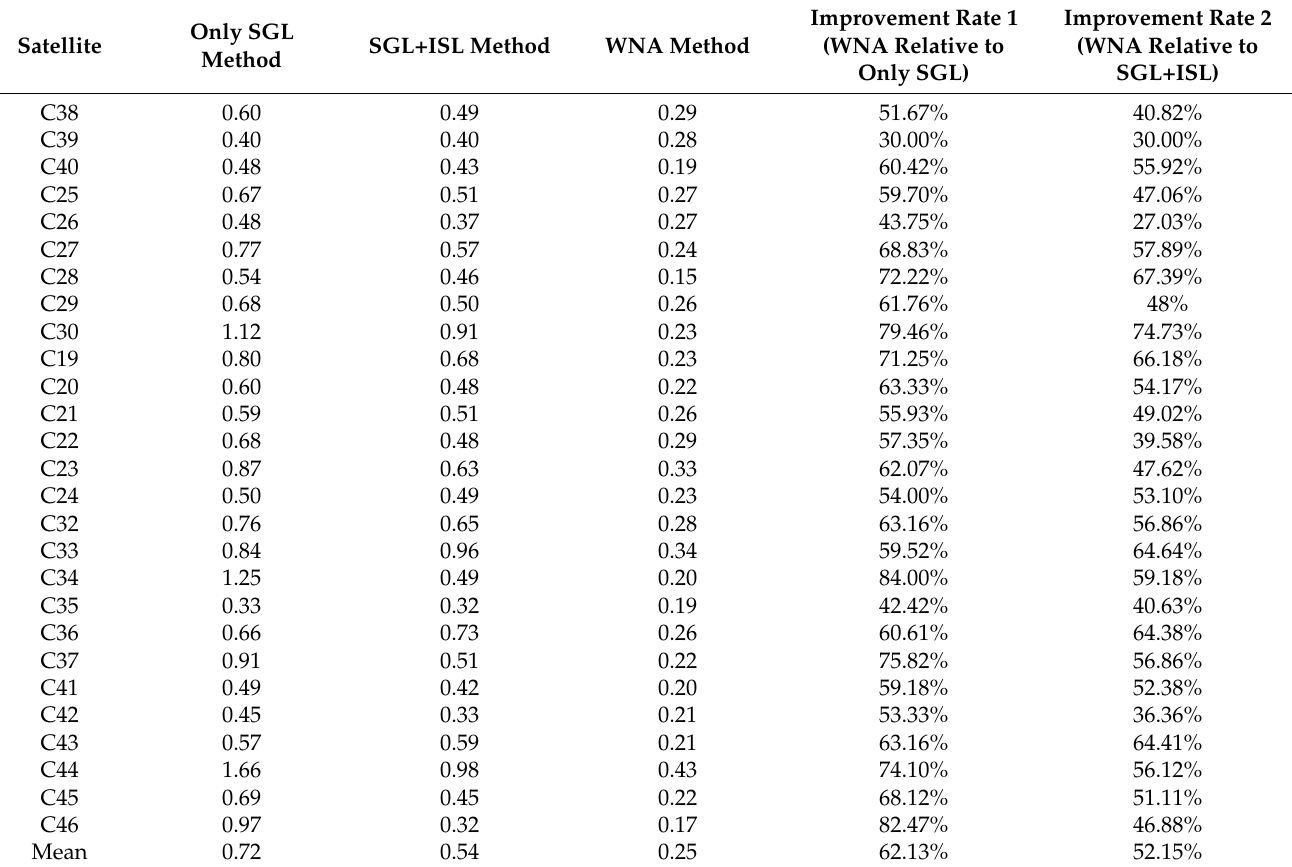
Table 2. RMS statistical results of prediction error (unit: